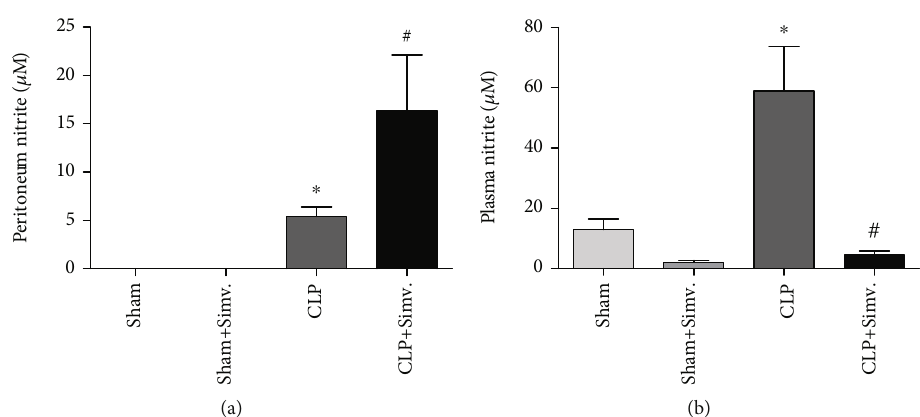
Figure 8: E ff ect of simvastatin on NO production in animals submitted to CLP. Septic SW mice were treated with simvastatin (2 mg/kg body weight) 6 hours after surgery. 24 hours after sepsis induction, plasma (a) and peritoneal lavage samples (b) were collected for NO quanti fi cation. Data represented as mean ± SEM of at least 6 animals. ∗ p < 0 : 05 , control vs. CLP+ vehicle, # p < 0 : 05 , CLP+vehicle vs. CLP +simvastatin.